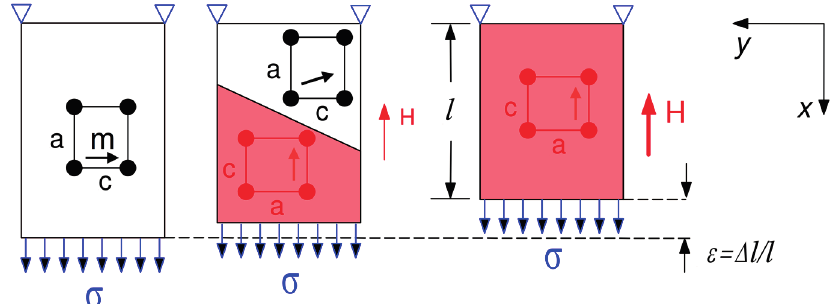
Figure 4. Schematic operation principle of the MSM effect for a 10M Ni–Mn–Ga